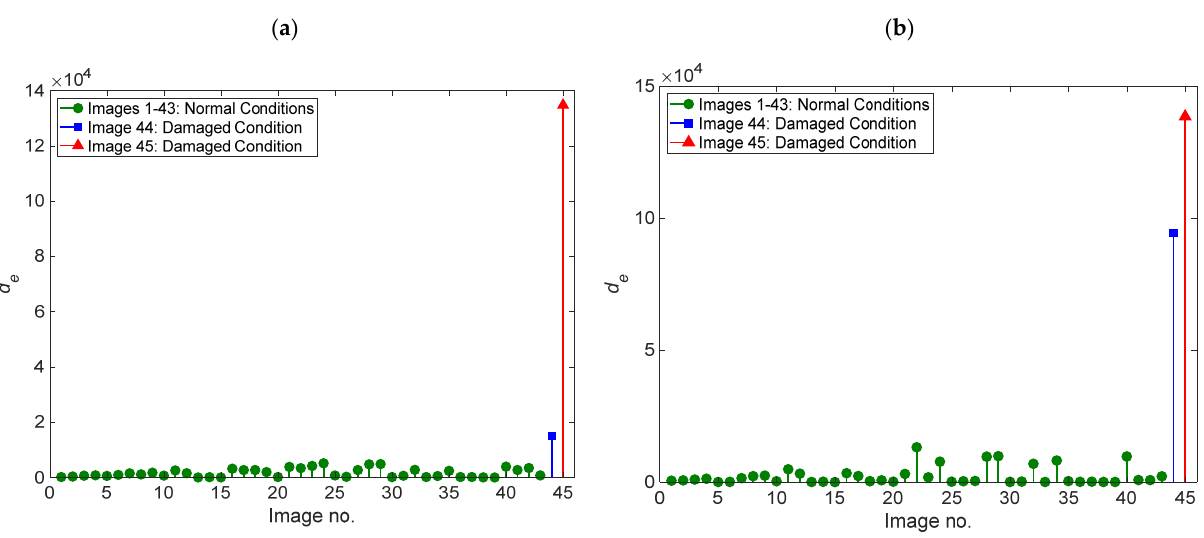
Figure 12. Decision-making for early damage detection: ( a ) HMC-ODTL-EMSD, ( b ) Figure 12. Decision ‐ making for early damage detection: ( a ) HMC ‐ ODTL ‐ EMSD, ( b ) SLS ‐ ODTL ‐ EMSD.